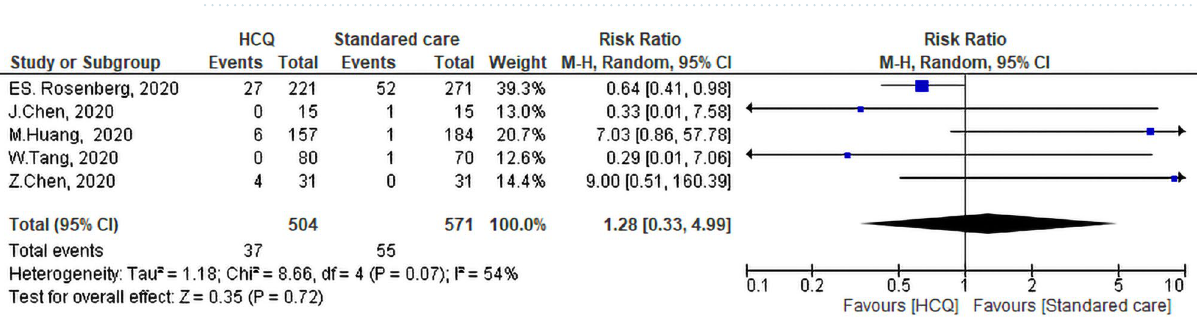
Figure 12. Side effects of the Hydroxychloroquine versus the standard care.